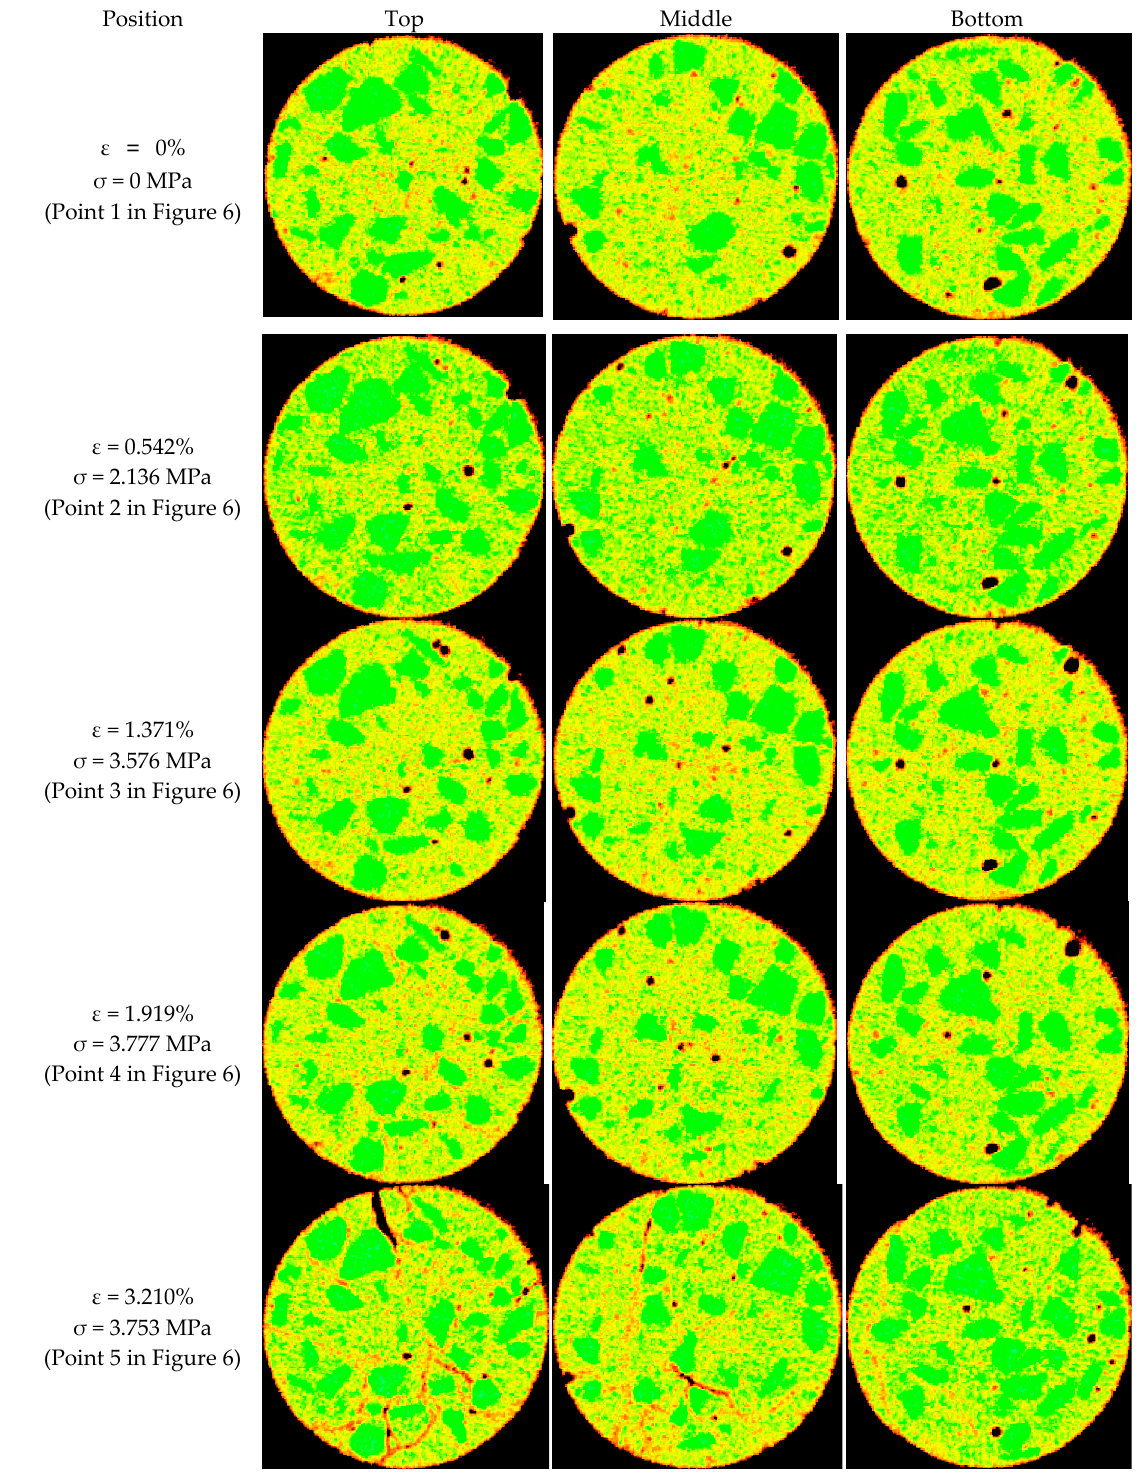
Figure 10. The reconstructed CT images of the CWRTB sample at the top, middle and bottom positions at five loading stages. The regions marked in orange indicate damage zones inside the sample.